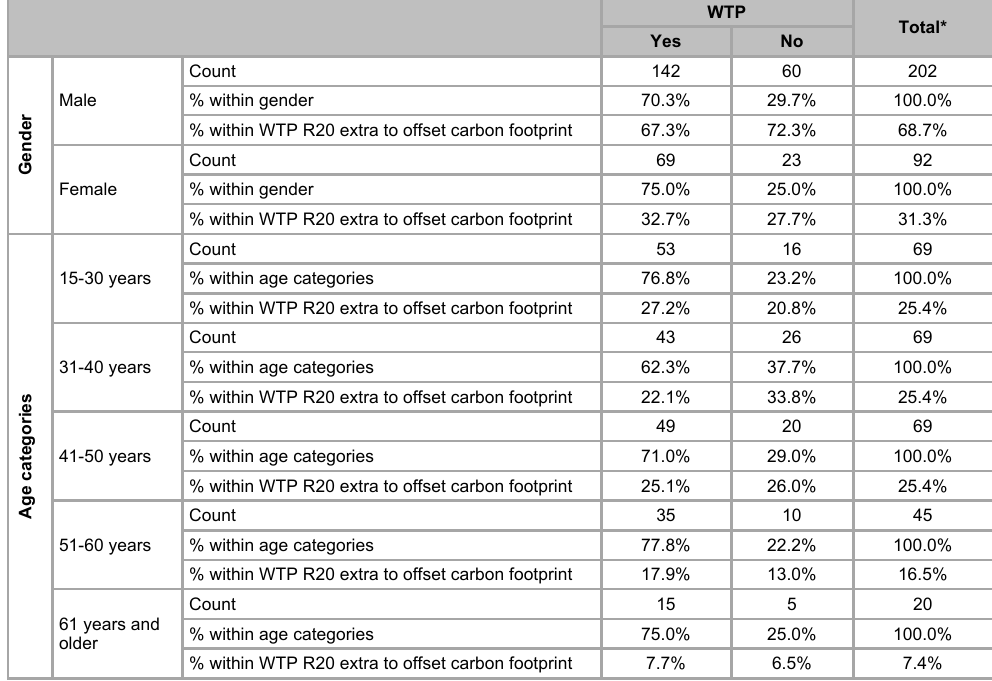
Cross-tabulation of WTP and gender and age